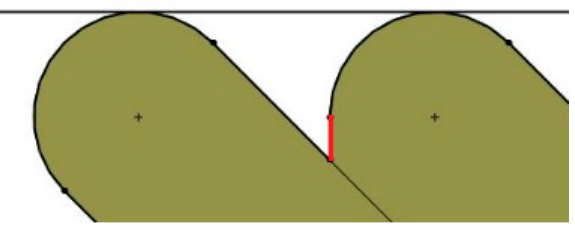
Figure 2. Schematic of the cross-section of two deposited filaments with print orientation angle of 45 ◦ . 2. The shape of the edges of the two filaments is considered to be the theoretical roughness profile of the lateral wall of the parts. In order to avoid profiles with negative draft angle from the vertical direction (which are not found in experimental roughness profiles), vertical lines are drawn in the area where the end of one filament adjoins the other filament, if necessary (see red line in Figure 2). 3. The total measurement length of the profiles was defined as the distance between the centers of the circumferences of the edges of the two layers (Figure 3).